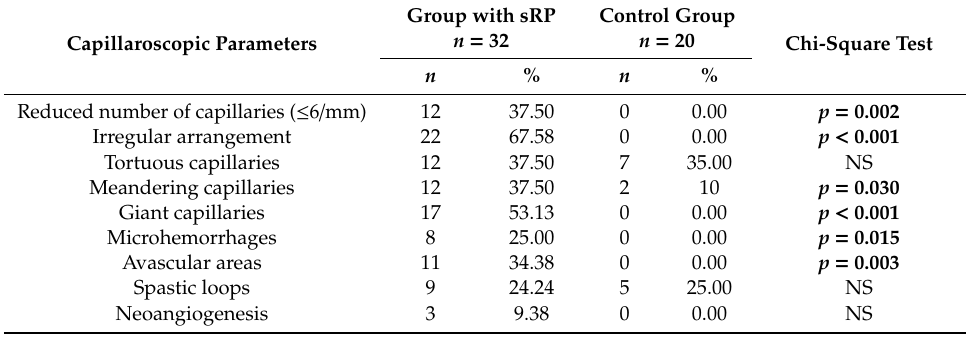
Table 4. Assessment of the qualitative capillaroscopic parameters in children and adolescents with secondary Raynaud’s phenomenon (sRP) compared with the control